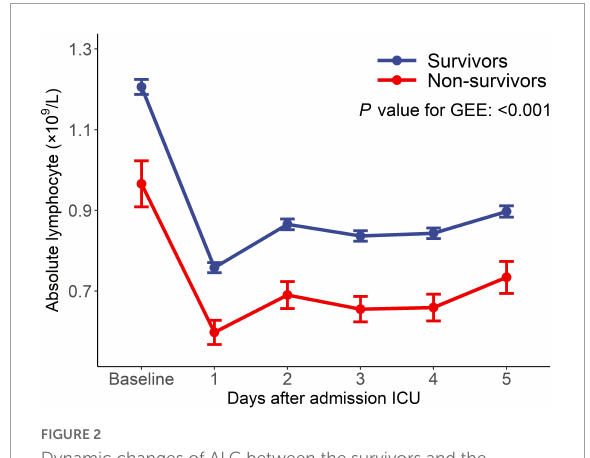
FIGURE2 Dynamic changes of ALC between the survivors and the